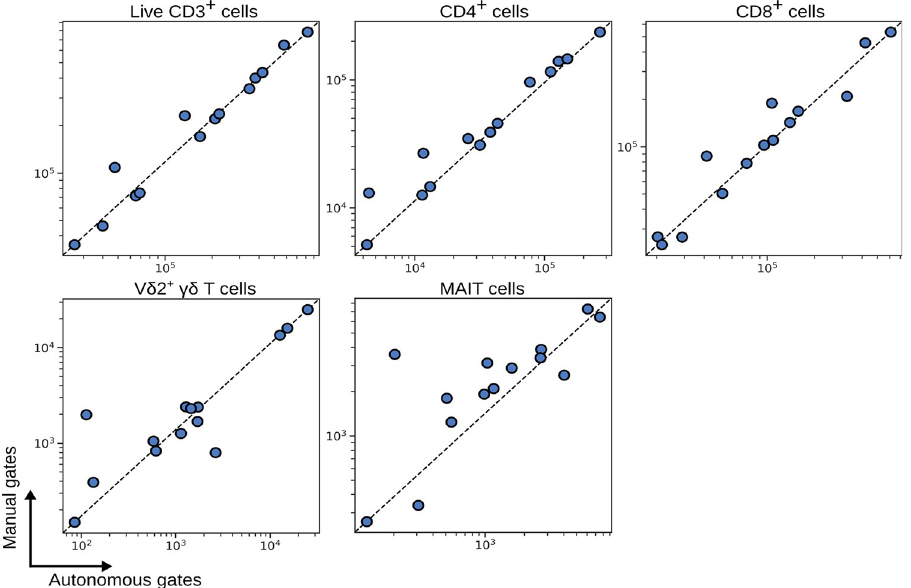
Fig 3. Number of events captured by autonomous gates for blood T cell subsets compared to the same subsets as defined by manual expert gates. Each symbol depicts results obtained with cells from an individual